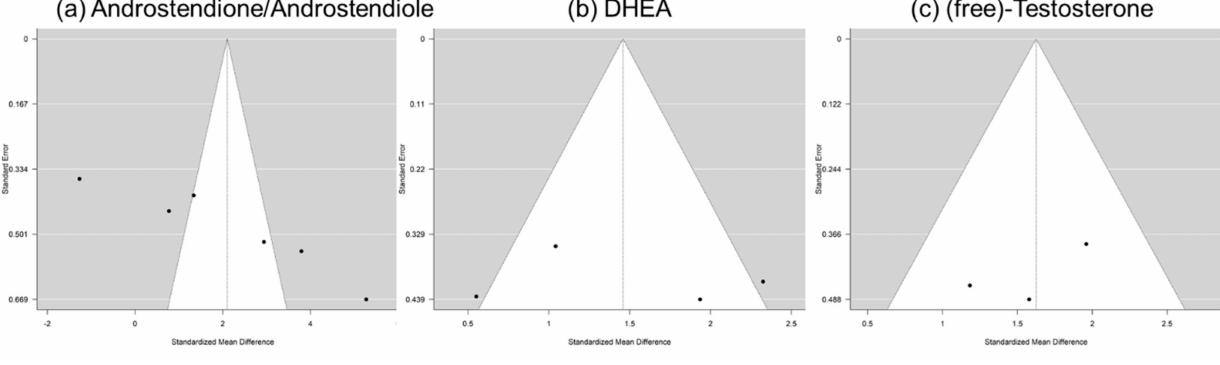
Figure 6. Funnel plots for girls: x -axis—standardized mean difference; y -axis—standard error for ( a ) androstene- dione/androstenediol, ( b ) DHEA-(C/S), and ( c ) (free)